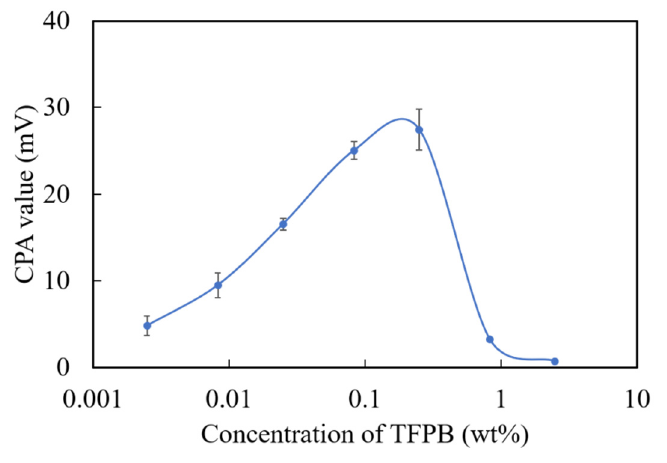
Figure 9. The relationship of CPA values and TFPB contents in TFPB-NPOE membranes. The results are expressed as means ± SD ( n = 16, 4 membranes × 4 times).